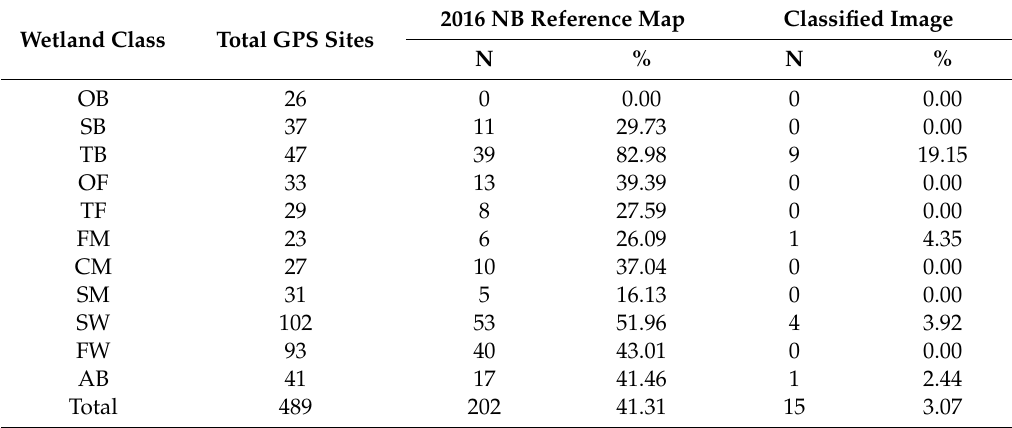
Table 17. Comparison between the 2016 NB reference map and the classified image for the number and percentage of the in-situ GPS wetland sites that were not identified as a wetland